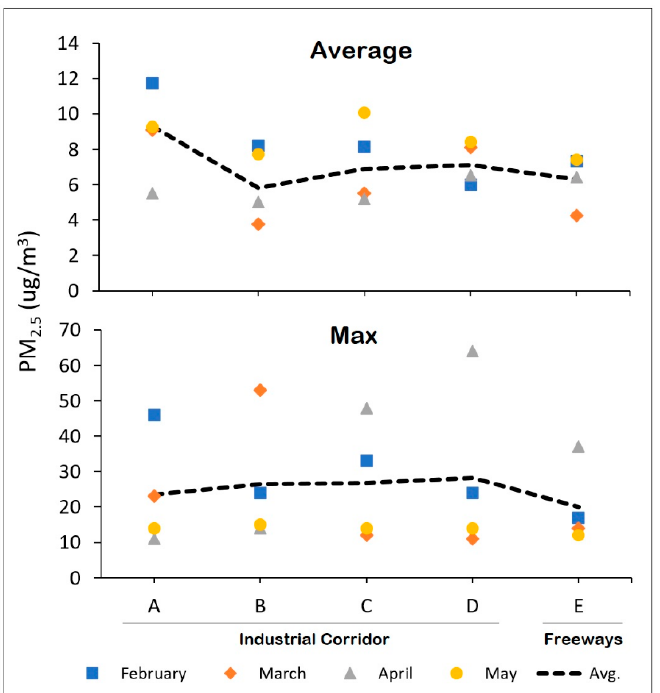
Figure 3. Average (over entire sampling day) and one-minute maximum PM 2.5 concentrations across each of four monthly sampling days and across each of five walking routes (A–E) measured simultaneously.